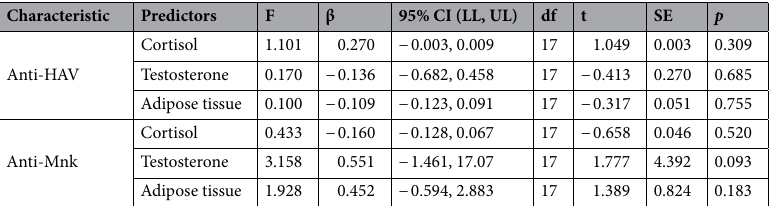
Table 5. Relationship between reactivity of the immune system, steroid hormones levels, and adipose tissue. Anti-HAV antibodies against hepatitis A, Anti-Mnk antibodies against meningococcus. β represents a standardized β estimate.